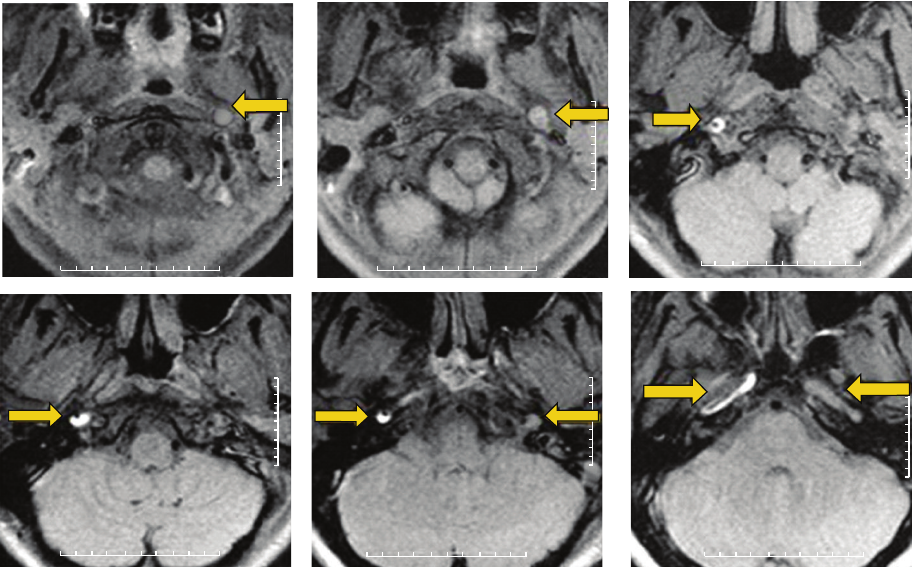
Figure 5: MRI T1-FAT-SAT-weighted images showing the dissecting process visible as a hypersignal in the wall of both ICAs as well as an enhancement of ICA diameter (arrows).